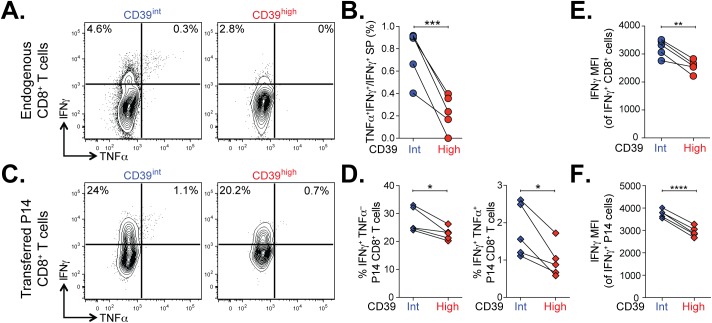
Terminally exhausted CD8+ T cells marked by high levels of CD39 are most impaired in their effector function.(A) Representative plots showing the production of IFN-γ and TNFα in CD39int or CD39high CD8+ T cells 36 days following LCMV Clone 13 infection. (B) Quantification of cells in (A) that produce both TNFα and IFN-γ relative to IFN-γ only. (C, D) Cytokine production by P14 cells (C) gated from an infection as in (A) and summary of IFN-γ and TNFα producing cells. (E, F) Mean fluorescence intensity (MFI) of IFN-γ in IFN-γ positive endogenous (E) and transferred P14 cells (F). Statistical significance was assessed with paired Student’s t-test. *P < 0.05, **P < 0.01, ***P < 0.001, ****P < 0.0001.